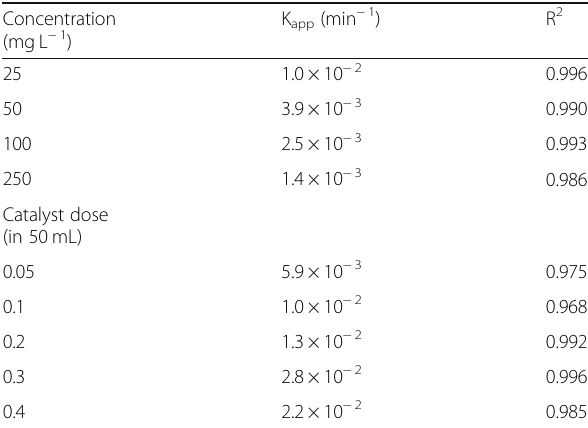
Table 1 Langmuir-hinshelwood kinetic parameters for photocatalytic removal of phenol as a function of concentration and catalyst